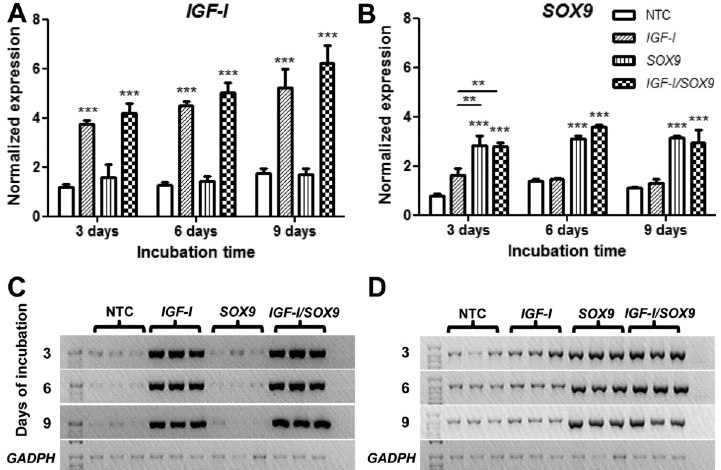
Figure 1. Chondrocyte expression of IGF-I , SOX9 , and GAPDH . The panels show A , the results of IGF-I and B , SOX9 densitometry, and C and D , cDNA electrophoresis bands. The columns in A and B indicate the amplicon densitometry from the non-transfected chondrocytes (NTC), or those transfected with pCMV-SPORT6 IGF-I ( IGF-I ), pCMV-SPORT6 SOX9 ( SOX9 ), or both plasmids ( IGF-I/SOX9 ). Data are reported as the average and standard deviation of the density values normalized to the corresponding GAPDH density of 9 assessments. ***P o 0.001, NTC vs IGF-I , SOX9 or IGF-I/SOX9 transfected chondrocytes (two-way ANOVA with Bonferroni post hoc tests). Differences in IGF-I/SOX9 and SOX9 vs IGF-I on day 3 (**P o 0.01) are indicated with lines (two-way ANOVA with Bonferroni post hoc